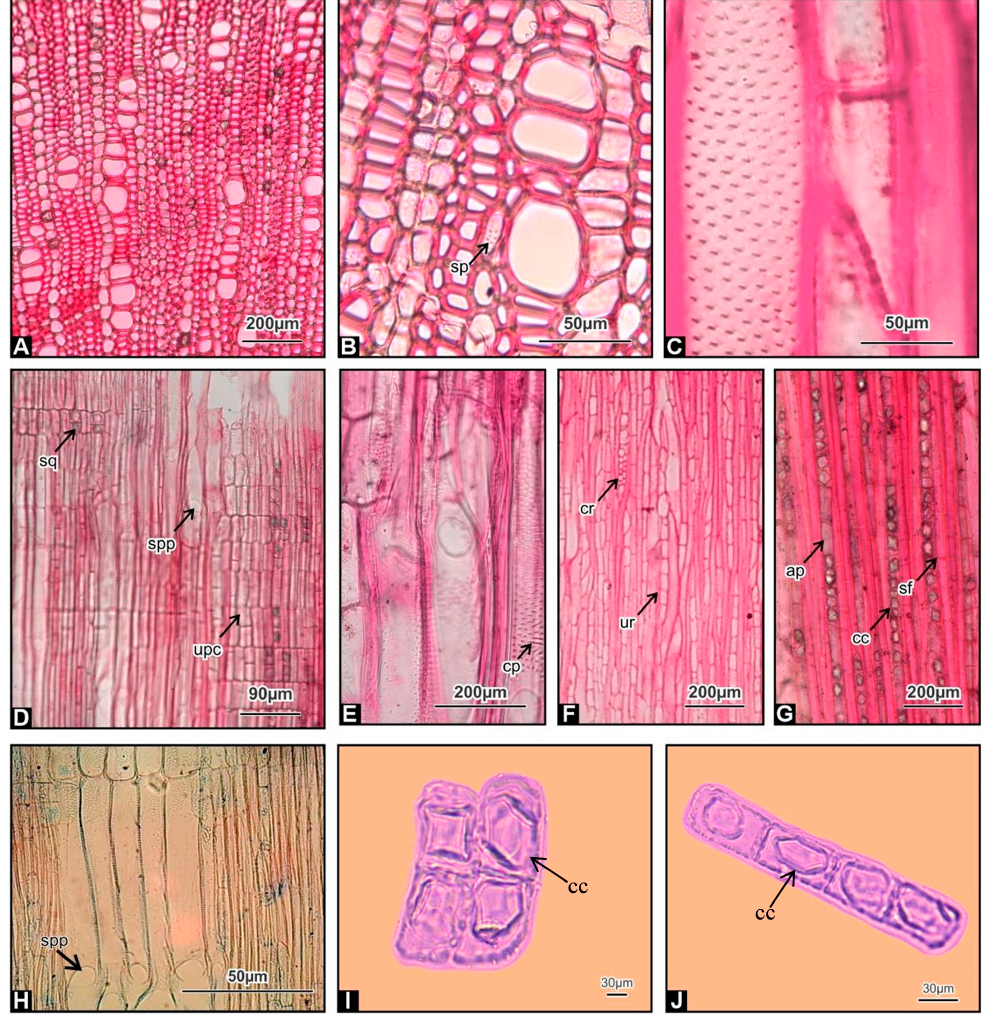
Figure 2. Wood anatomy of Kopsia fruticosa Roxb. stem: ( A ) TS revealing a radial arrangement of vessels; ( B ) magnified image revealing scanty paratracheal parenchyma; ( C ) TLS revealing vestured pits (alternate); ( D ) RLS revealing simple perforation plate, upright and square cells; ( E ) TLS image of simple perforation plate and coalescent pit; ( F ) image of uniseriate and compound rays; ( G ) image of rhomboidal shape calcium oxalate crystals in axial parenchyma; ( H ) RLS revealing storied arrange- ment of vessels; ( I ) square parenchyma cells with chambered calcium oxalate crystals; ( J )